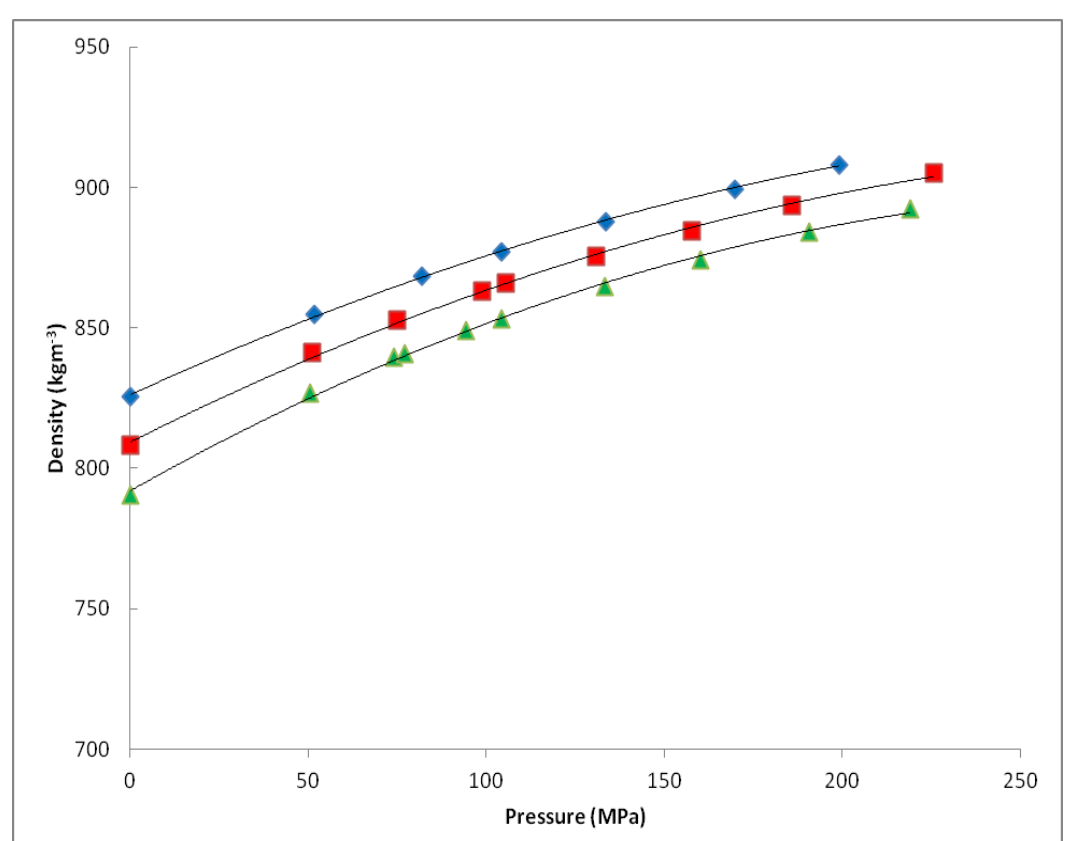
Figure 7. Variation of density for Fuel 3 with temperature. ♦ 298 K, ■ 323 K, and ▲ 348